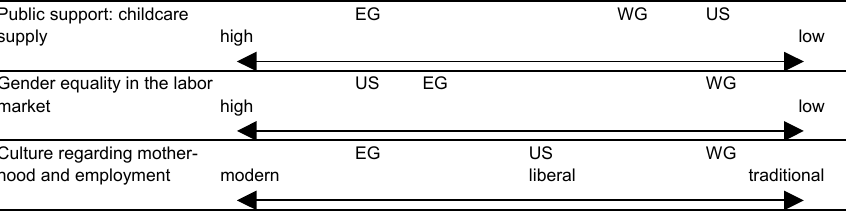
Table 5 Ranking the United States (US), West Germany (WG), and East Germany (EG) along Three Important Context